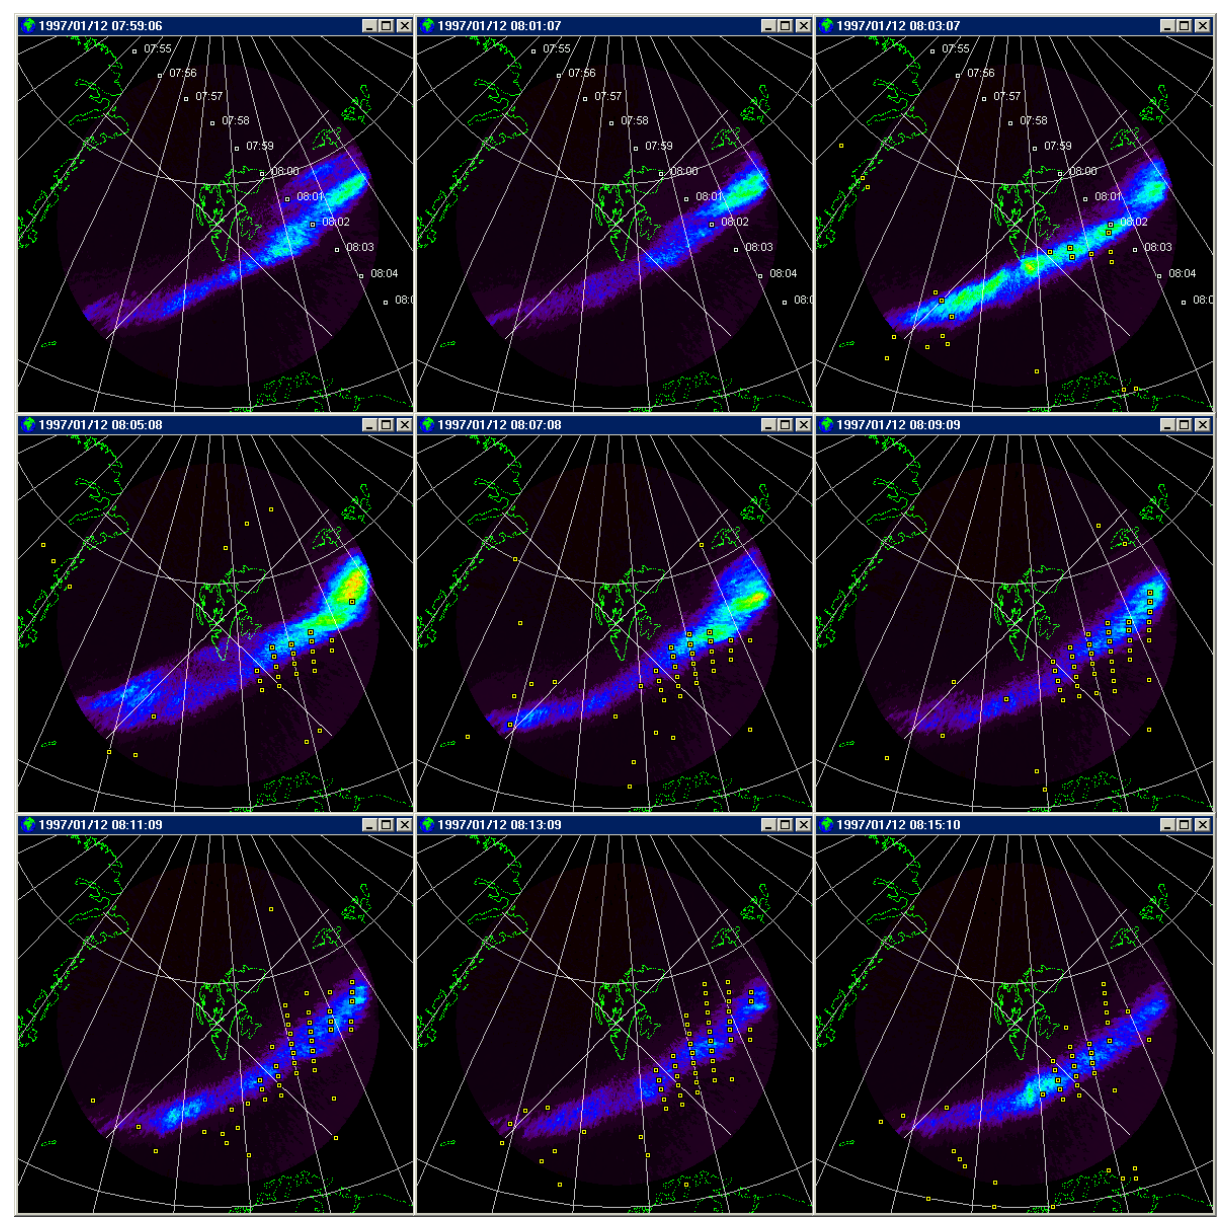
Fig. 7. Sequence of 630nm all-sky images from Longyearbyen for the time interval 07:59:06 to 08:15:10 UT overlaid with yellow markers, indicating range gates where spectral widths of the CUTLASS Finland HF radar are > 220m/s. In the first three panels the FAST footprint is also